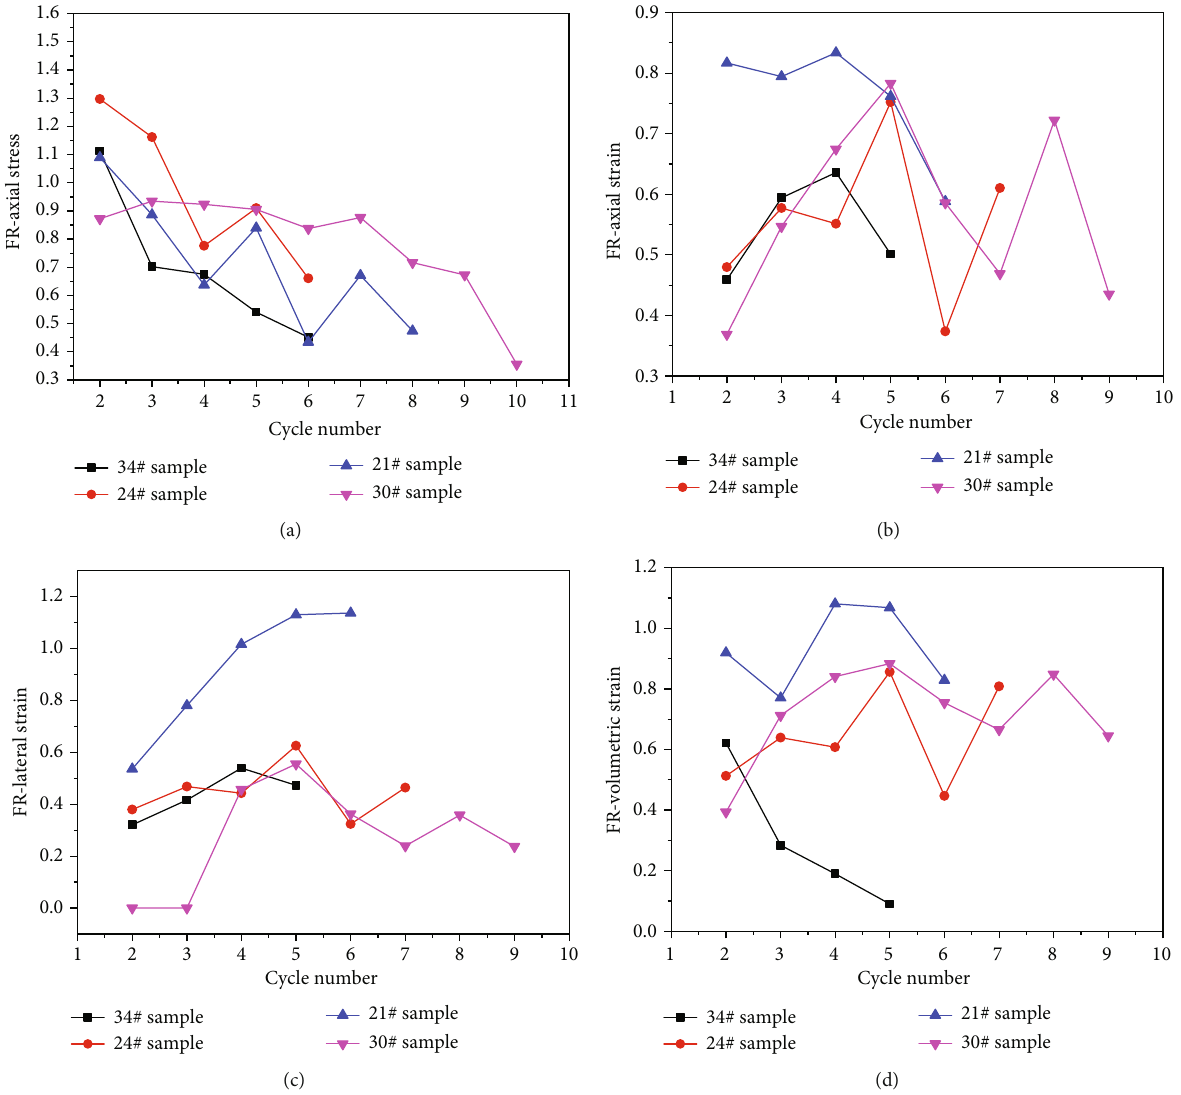
Figure 18: The main frequency characteristics of the tested samples during fracturing. (a – d) The sample IDs are NFG-34, NFG-24, NFG-21, and NFG-30, respectively. The corresponding natural fracture volume ratios are 0.19%, 0.15%, 0.13%, and 0.11%,